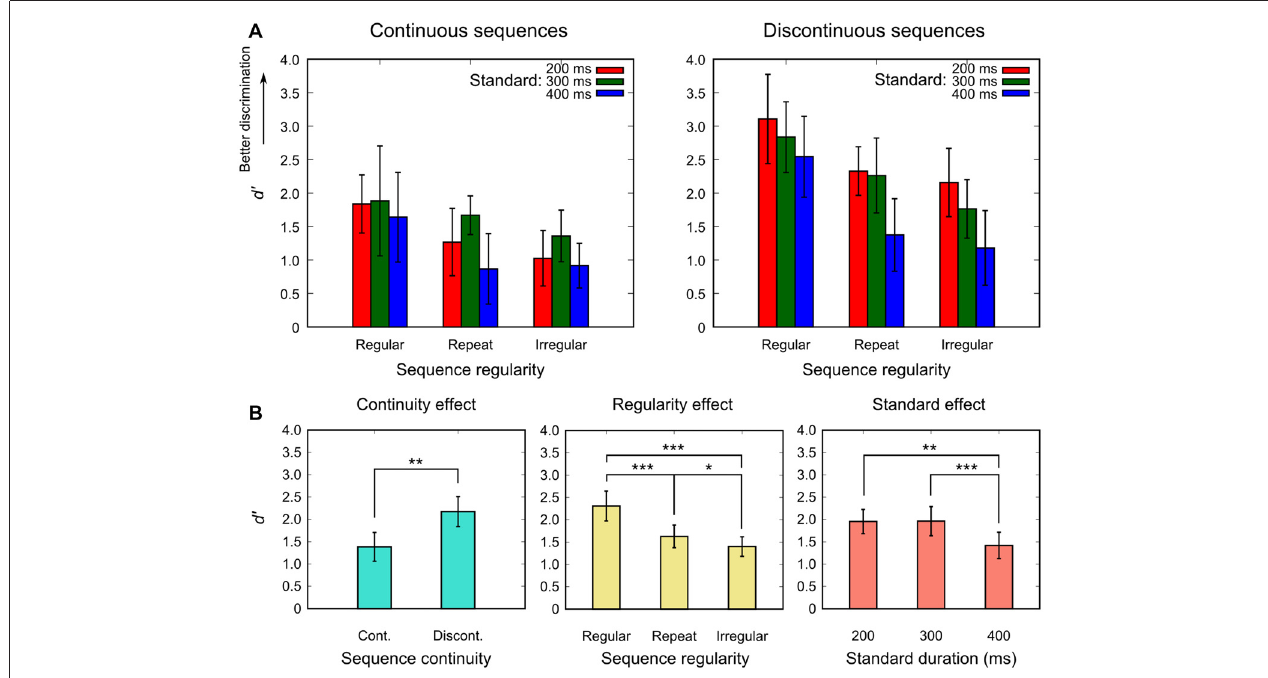
FIGURE 4 | Mean d (cid:48) for each experimental condition of the regularity-varied session (A) , and the results of the post hoc contrasts for all main effects that were significant in the omnibus ANOVA (B) . Bars represent 95% confidence intervals. Asterisks indicate significant differences ( ∗ p < 0.05, ∗∗ p < 0.01, ∗∗∗ p <